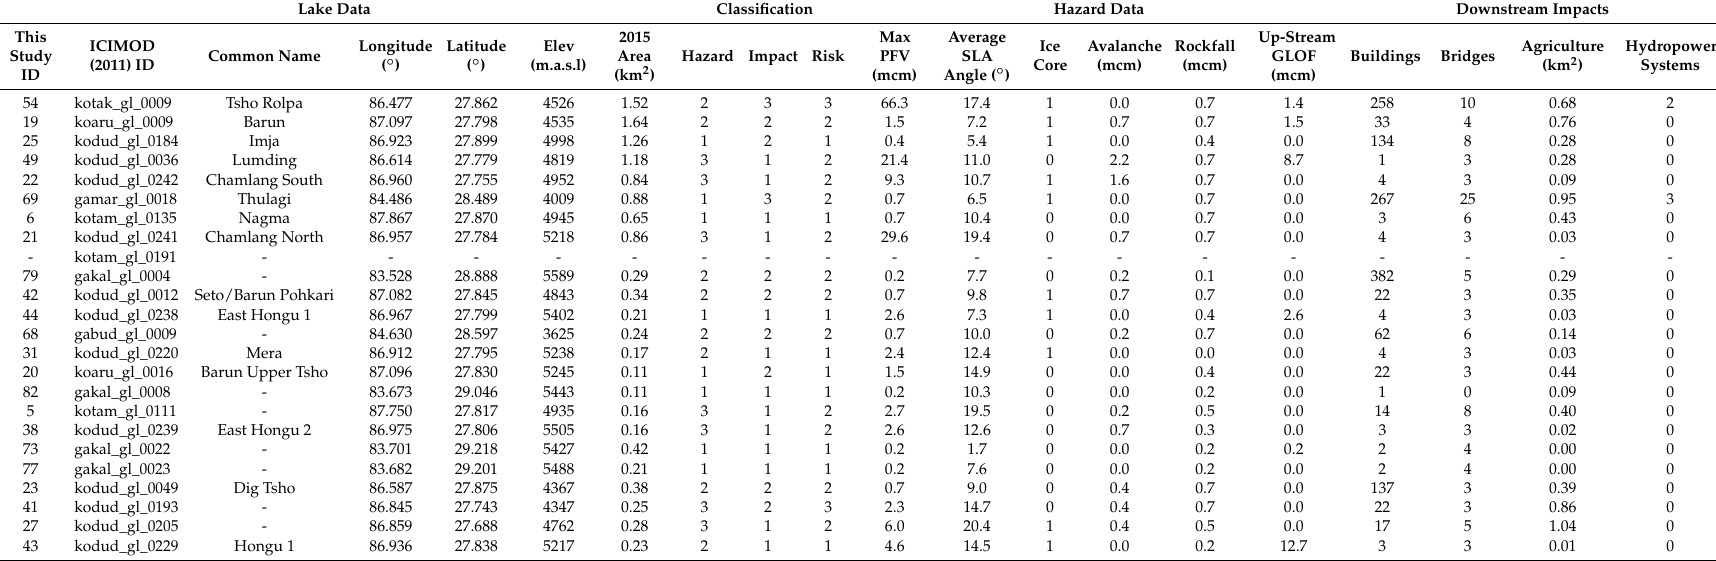
Table 2. Hazard parameters, downstream impacts, risk classification, and lake data associated for lakes that were identified by ICIMOD (2011) [24] and Mool et al. (2001) [23] as being potential high hazards. Hazard, downstream impact, and risk classification values refer to low (0); moderate (1); high (2); and very high (3). Ice core value of 1 indicates a potential ice core. Additional details on all lakes are provided in the Supplementary Materials (Table